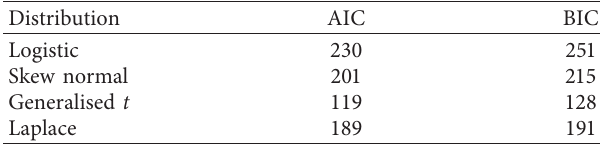
Laplace 141 Table 7: Marginal distribution of our exchange rate residuals. Distribution